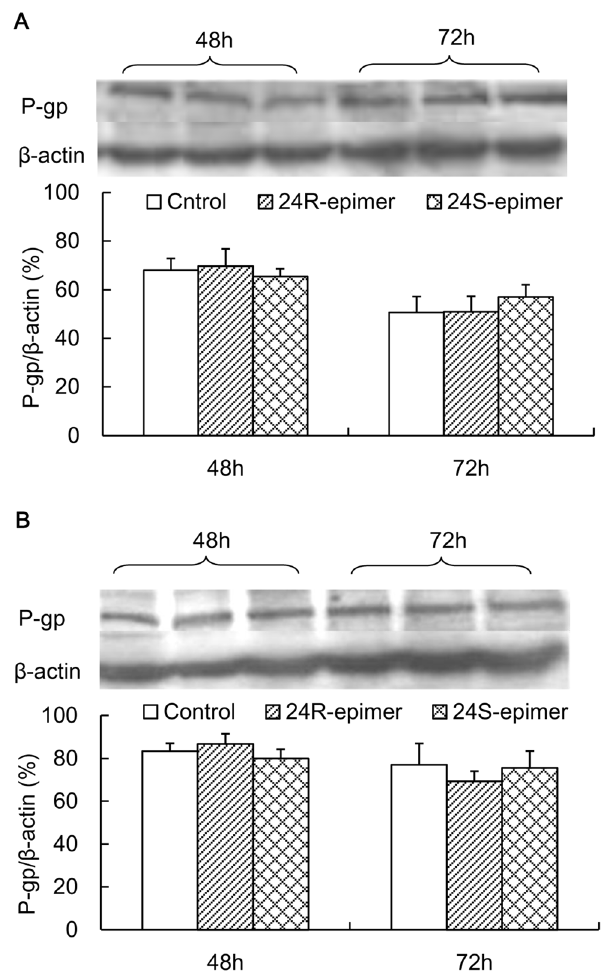
Figure 7. Effects of 24R-epimer and 24S-epimer on P-gp expression levels in Caco-2 cells. Cells were exposed to 24R- epimer or 24S-epimer at concentrations of 1 m M (A) and 10 m M (B), and 1% of DMSO as a solvent control for 48 and 72 h. The bar graphs show the P-gp protein band intensity corrected by that of b -actin.